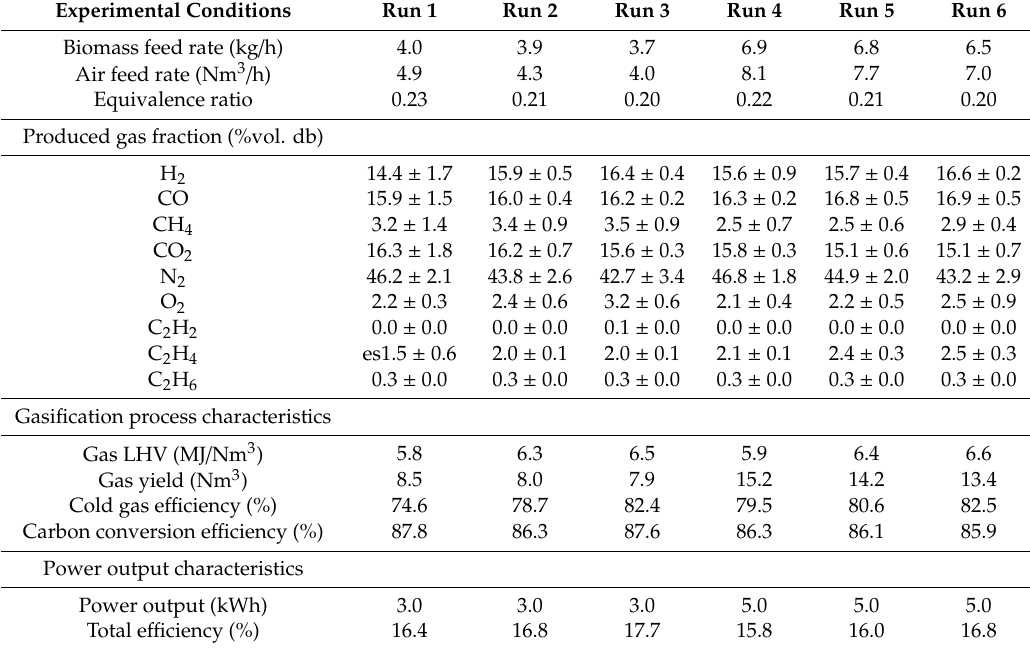
Table 5. Experimental operating conditions and producer gas analysis for brewer’s spent grains (BSG). Experimental Conditions